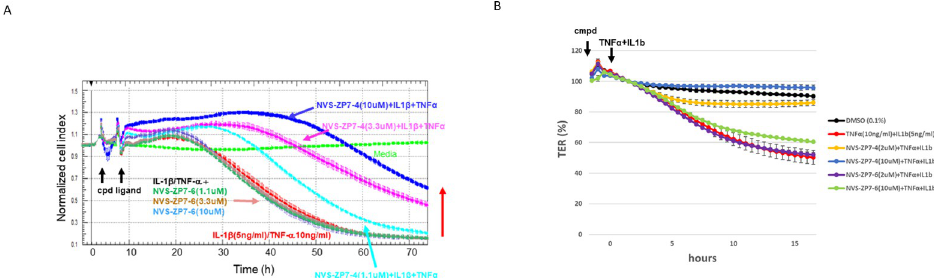
Fig 1. Zip7 zinc transport is involved in IL-1 β /TNF- α signaling in RPE cells. A: Impedance was measured in confluent ARPE-19 cells for 72h in media, media + IL-1 β (5 ng/mL)/TNF- α (10ng/mL), media + IL-1 β /TNF- α + NVS-ZP7-4 or media + IL-1 β /TNF- α + NVS-ZP7-6 (inactive analog of NVS-ZP7-4). B: Challenge of human iPS- derived RPE cells by IL-1 β /TNF- α in the presence of NVS-ZP7-4 increased transepithelial resistance relative to cells treated with IL-1 β /TNF- α alone. Inclusion of NVS-ZP7-6 during challenge with IL-1 β /TNF- α resulted in impedance